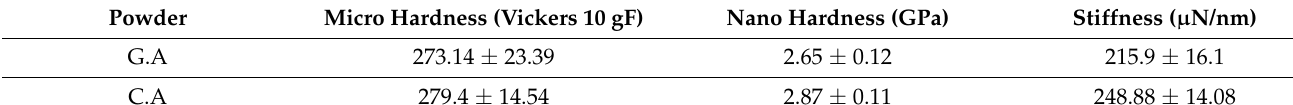
Table 6. Micro ‐ and nanohardness measurement data on the powders.